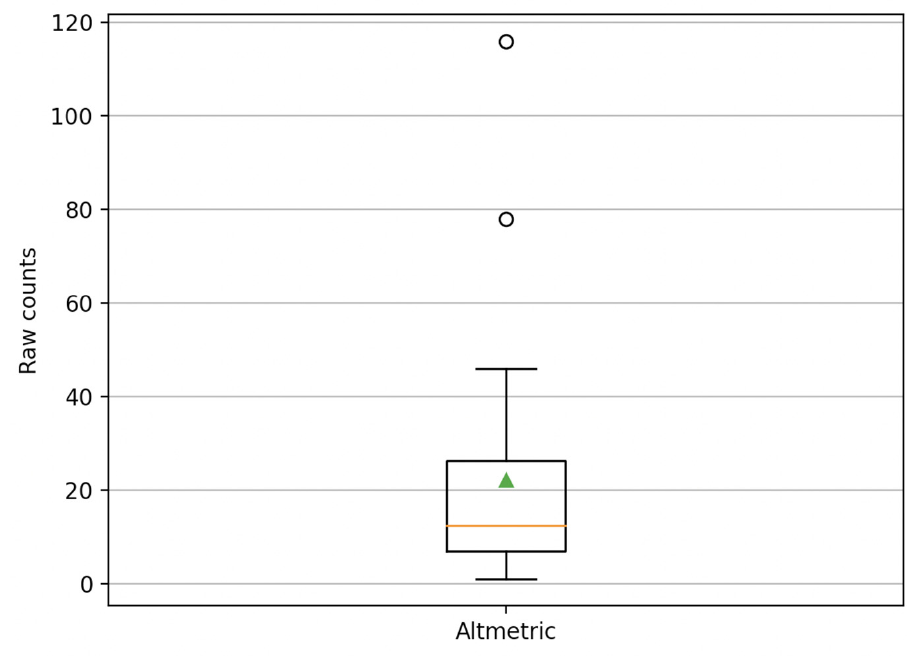
Figure A8. Research papers associated with JOHD/RDJ data papers: average Altmetric scores.